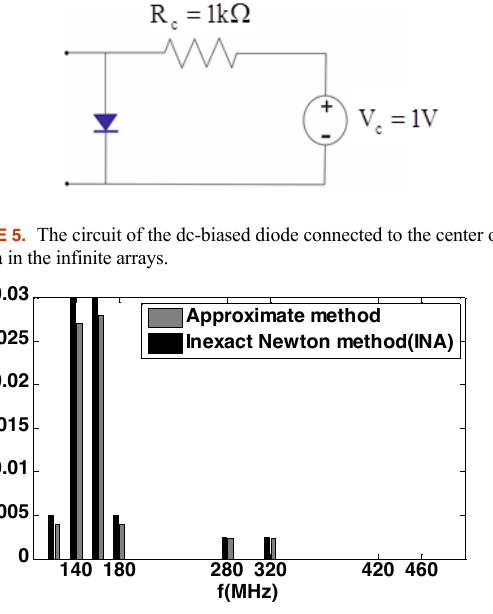
FIGURE 6. Magnitude of induced voltage across the p-n diode based on the INA [8] and the approximate method in this paper.